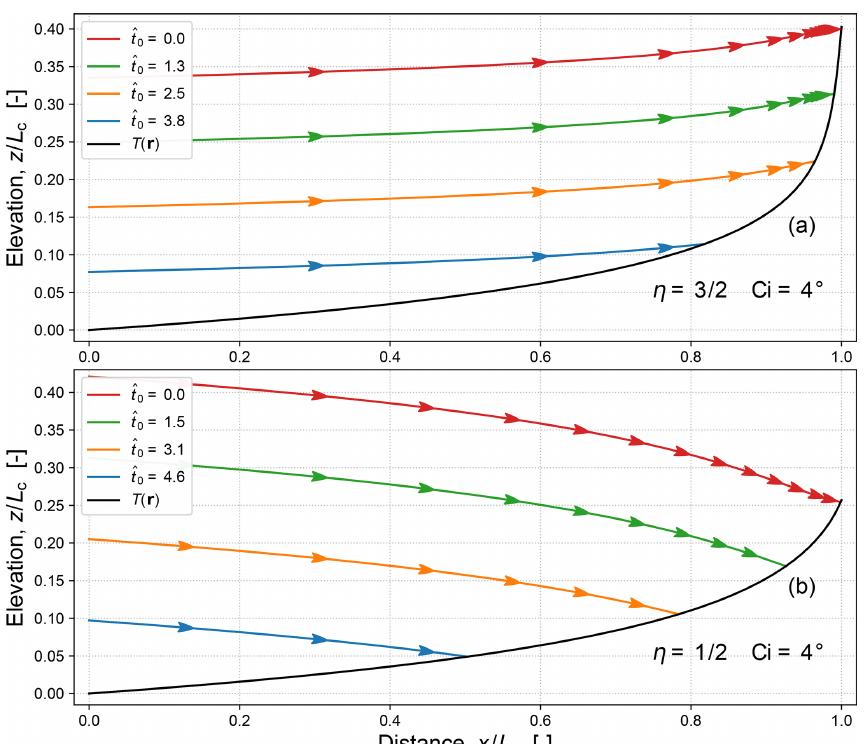
and (b) η = 1 and with µ/η = 1 and 2 2 2